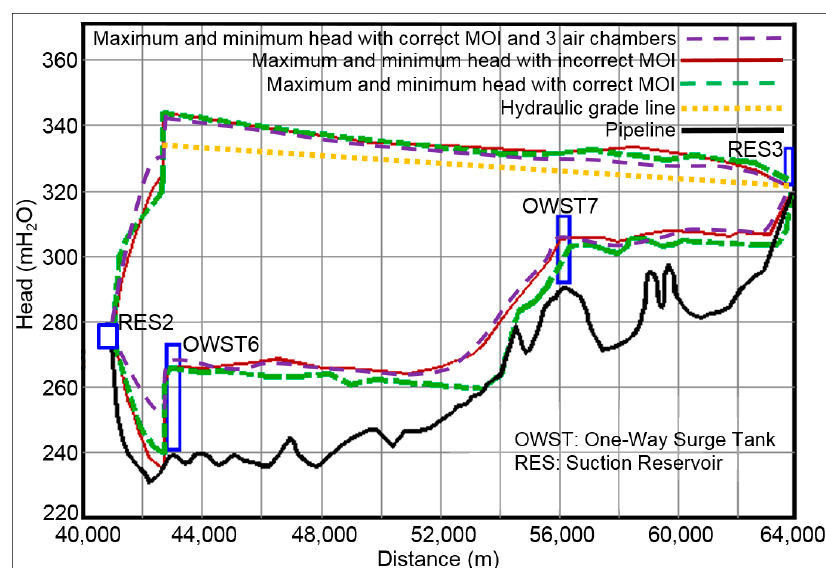
Figure 4. Maximum and minimum head envelopes for the second pipeline segment, considering the incorrect moment of inertia (original design), the correct moment of inertia (MOI), and the correct moment of inertia and the three additional air chambers, following the simultaneous power failure of the five pumps at Pumping Plant 2.